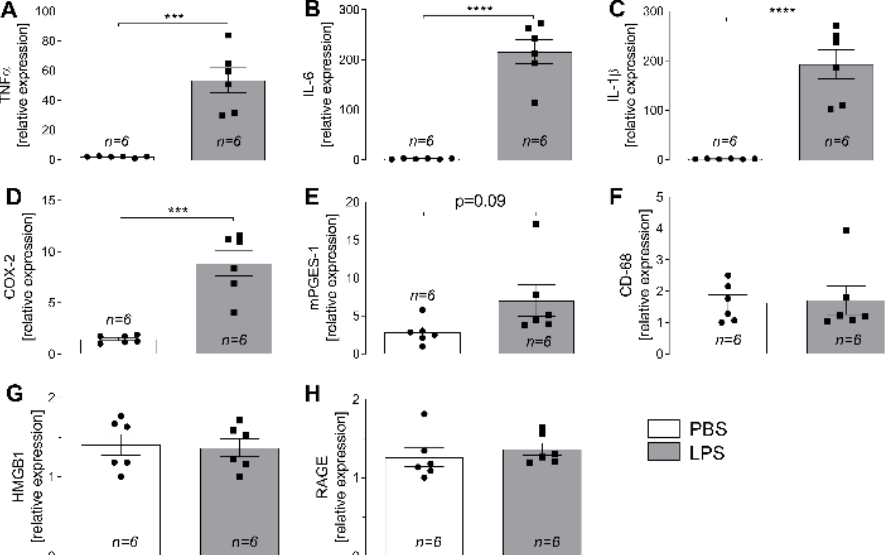
Figure 2 . Upregulation of inflammatory target genes in lumbar dorsal root ganglia (DRG) of